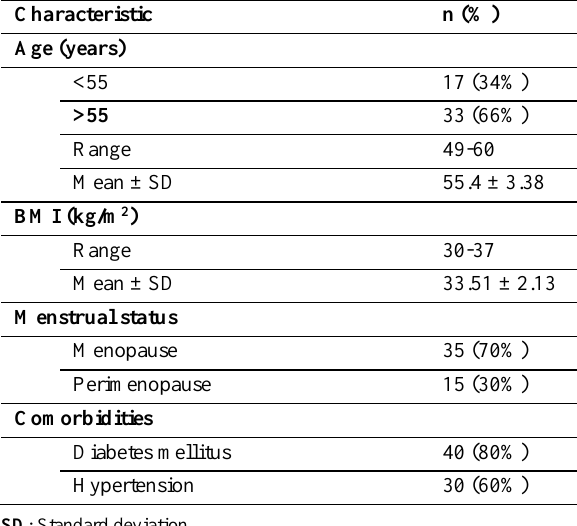
Table 1: Patients’